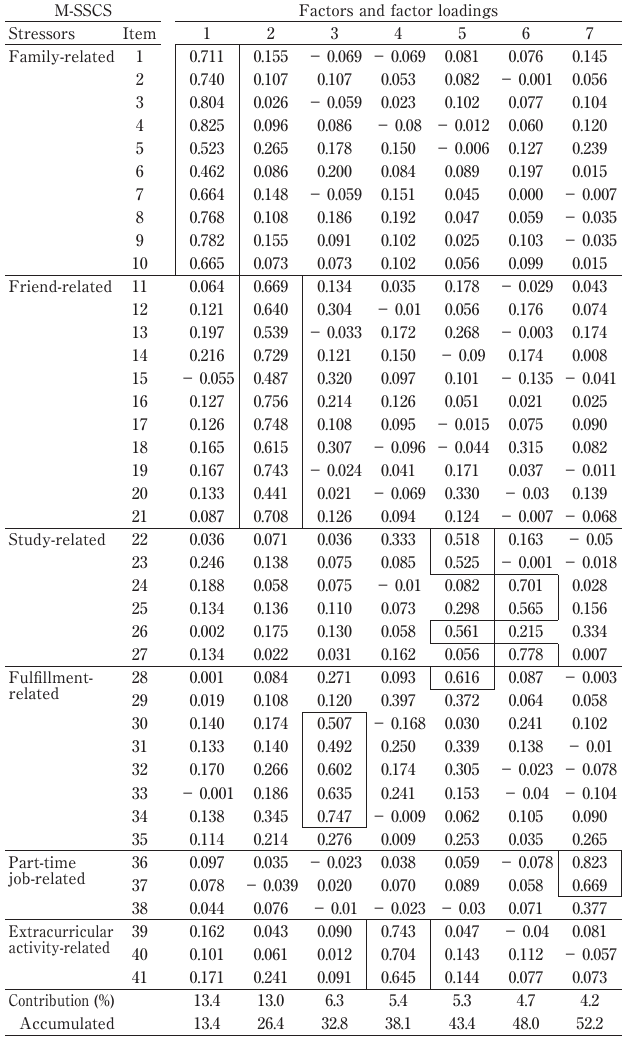
Table 2. Exploratory factor analysis (major factor method, varimax rotation) of the Modified Stressor Scale for College Student (M-SSCS) (n =